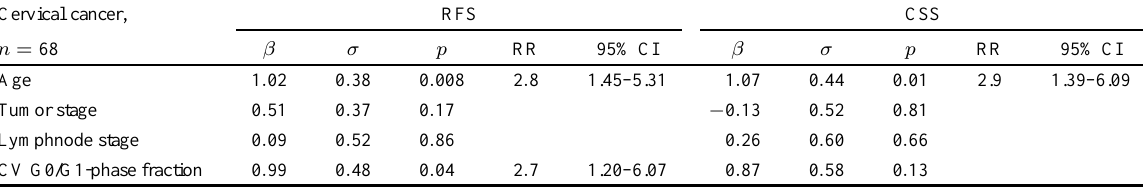
Primary cervical cancer ( n = 68). Cox-multivariate analysis of univariate prognostic relevant parameters for recurrence-free survival (RFS) and tumor-dependent overall survival (CSS). For all parameters multivariate analysis were performed. For all parameters the value of effect of covariable estimation ( β ), standard deviation ( σ ), relative risk (RR) and the belonging 95% confidence interval (95%CI) was determined Cervical cancer,